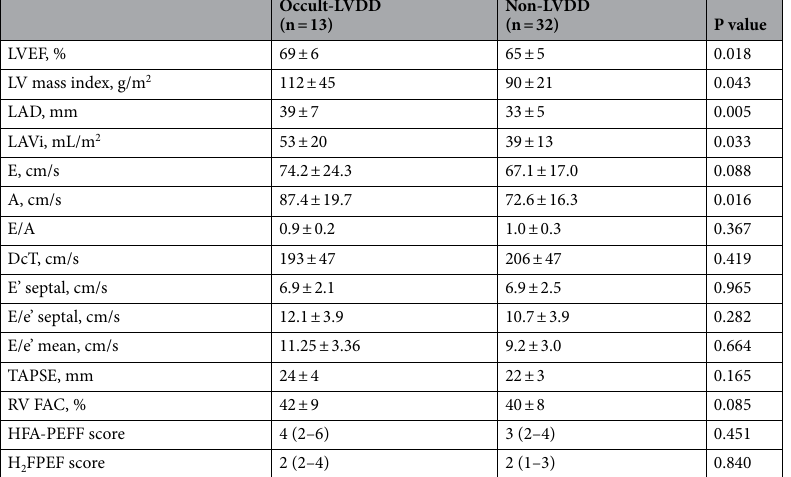
Table 3. Echocardiographic parameters. Values are reported as mean ± standard deviation (SD) or medians (25th, 75th interquartile ranges), where appropriate. E/e’ mean as average in respective value of septal and lateral E/e’. DcT, deceleration time; LAD, left atrial diameter; LAVi, left atrium volume index; LVDD, left ventricular diastolic dysfunction; LVEF, left ventricular ejection fraction; LV mass index, left ventricular mass index; RV FAC, right ventricular fractional area change; TAPSE, tricuspid annular plane systolic excursion.